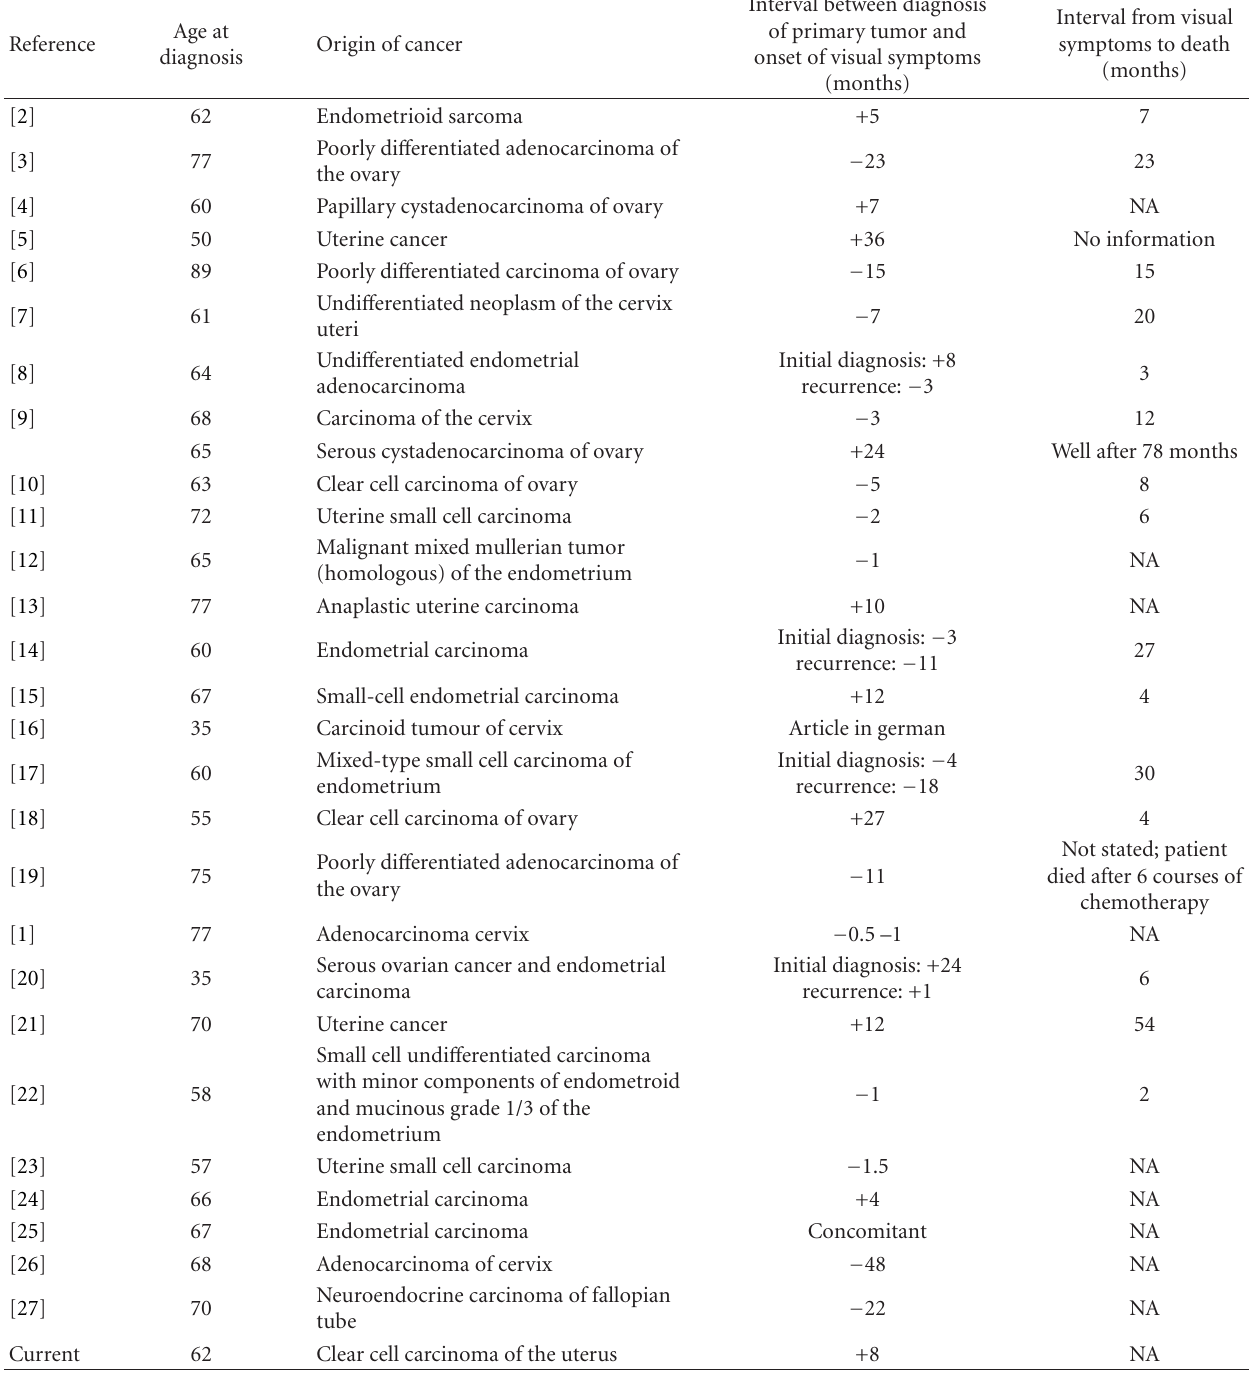
Table 1: Reported gynecologic cancers associated with paraneoplastic